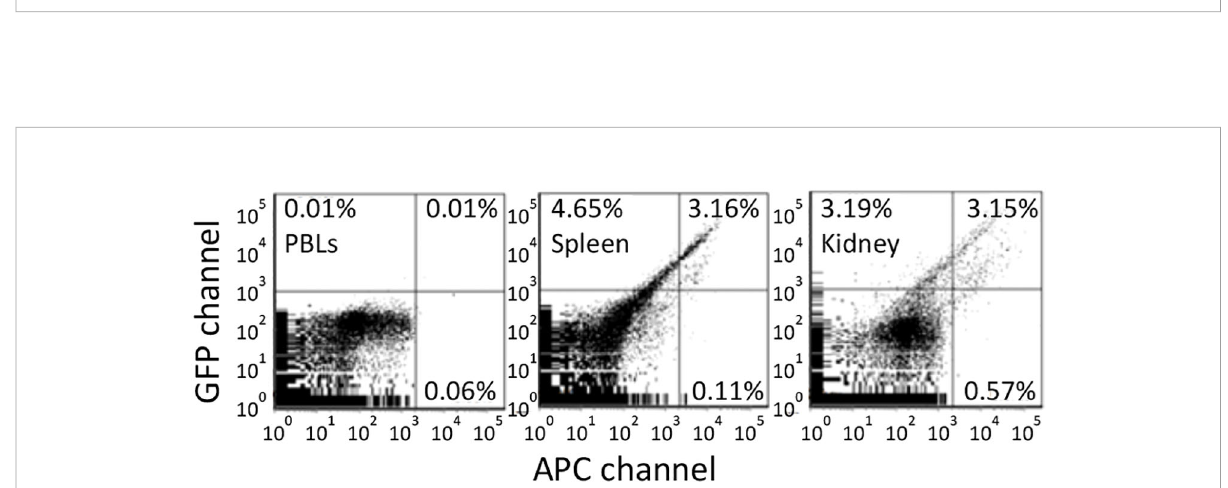
FIGURE 6 Antigen retention of far red tagged keyhole limpet hemocyanin (KLH) by melano-macrophages from immunized gold fi sh. Gold fi sh were immunized with KLH and boosted once over a year. These gold fi sh were then injected with Alexa Fluor 647 tagged KLH and FACS analyzed 13 days later. Green fl uorescence is in the GFP channel while far red is done in the APC channel. Background fl uorescence was determined using peripheral blood leukocytes. Spleen and Kidney leukocytes contained approximately 3% double positive and <1% single far red positive